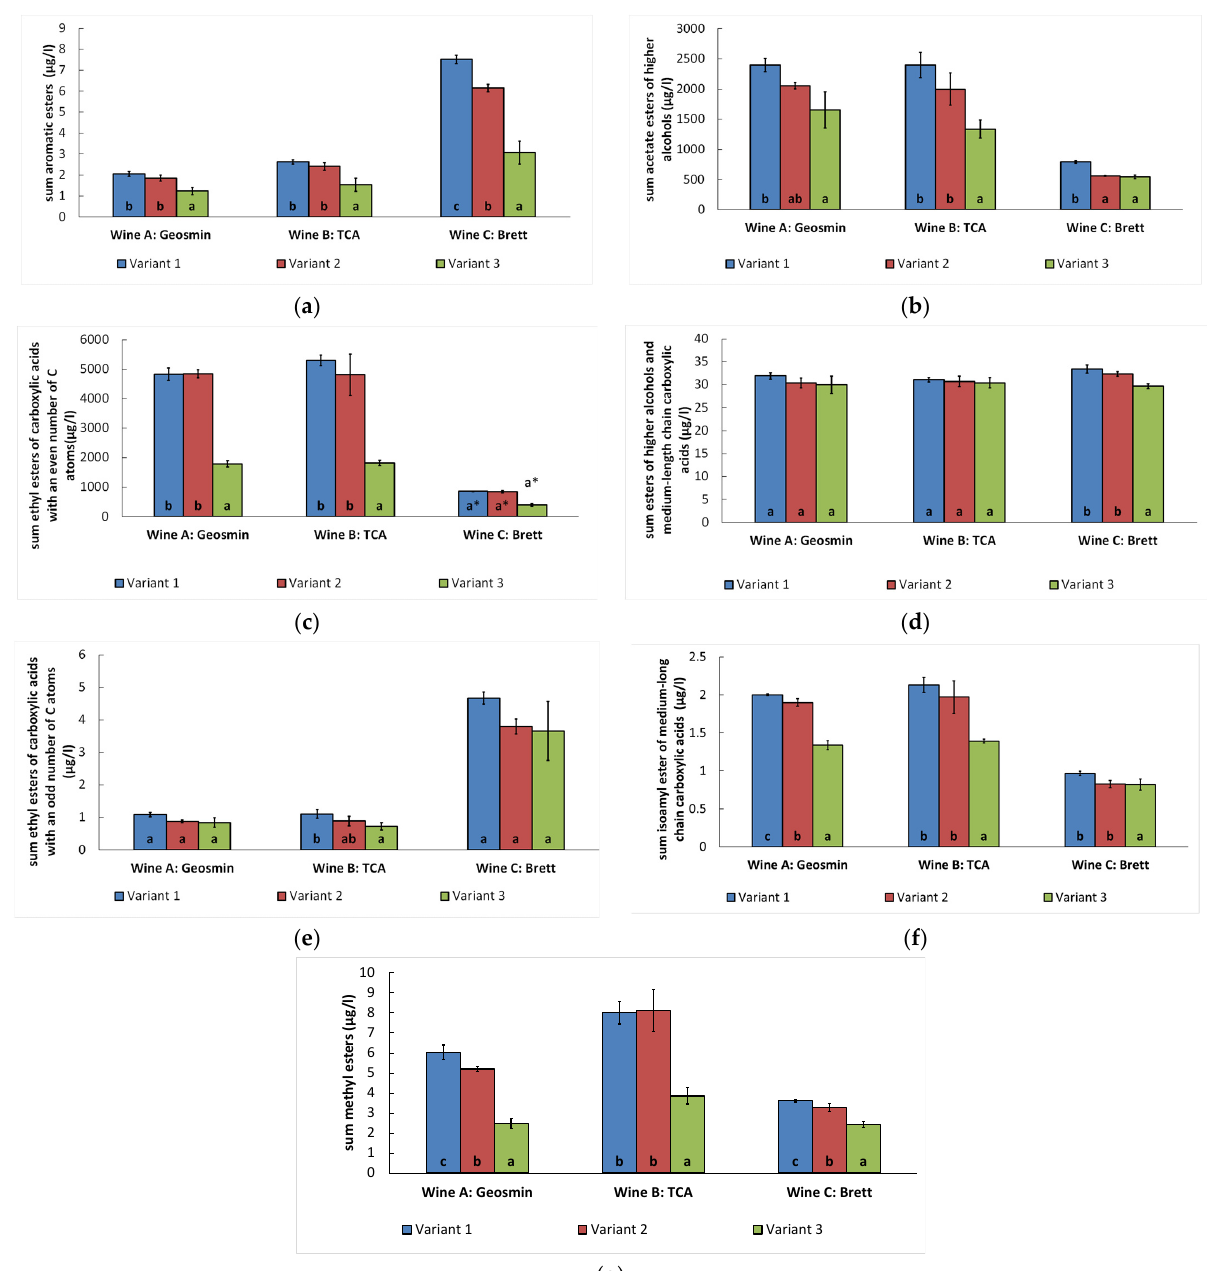
Figure 3. Reduction in ester compounds by filtration with conventional EKS layers (variant 2) and Fibrafix ® TX layers (variant 3) compared with the control sample (variant 1) in the small-scale test. Wine A was spiked with geosmin, wine B with TCA, and wine C with impact compounds of the “animal” phenolic character (Brett): ( a ) sum of aromatic esters; ( b ) sum of acetate esters of higher alcohols; ( c ) sum of ethyl esters with carboxylic acids having an even number of C atoms; ( d ) sum of esters of higher alcohols and medium-length chain carboxylic acids; ( e ) sum of ethyl esters with carboxylic acids having an odd number of C atoms; ( f ) sum of isoamyl esters with medium-length chain carboxylic acids; ( g ) sum of methyl esters. Significance test using simple ANOVA and post hoc test Tukey B Test; same letters mean no significant difference based on significance level p ≤ 0.05 with alphabetical order, starting at a (smallest value) to c (largest value). * No normal distribution; significance test using nonparametric Kruskal–Wallis test and pairwise comparisons based on Mann–Whitney U tests at significance level p ≤ 0.10.